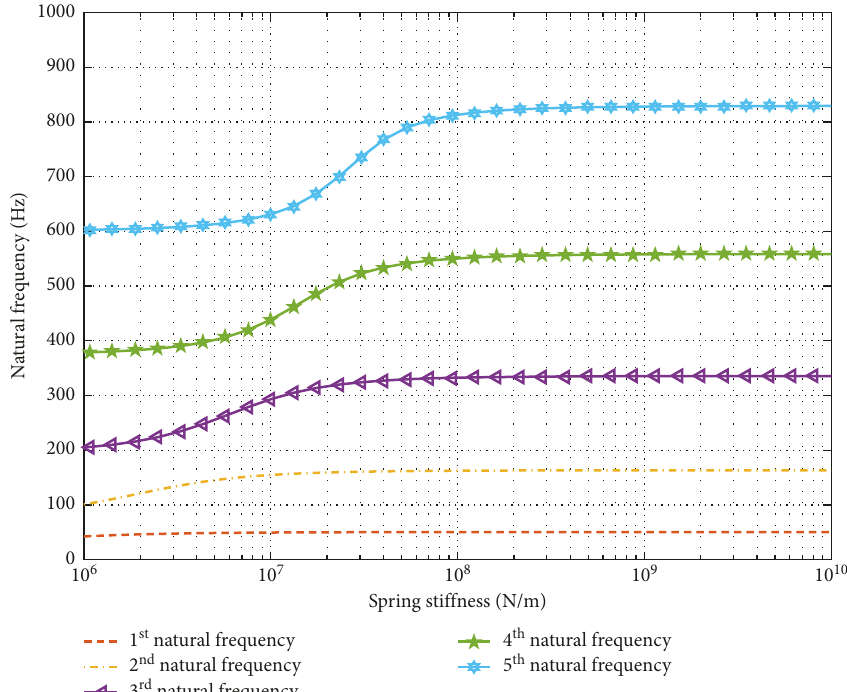
Figure 5: Analytical natural frequencies obtained for different spring stiffness Δ K